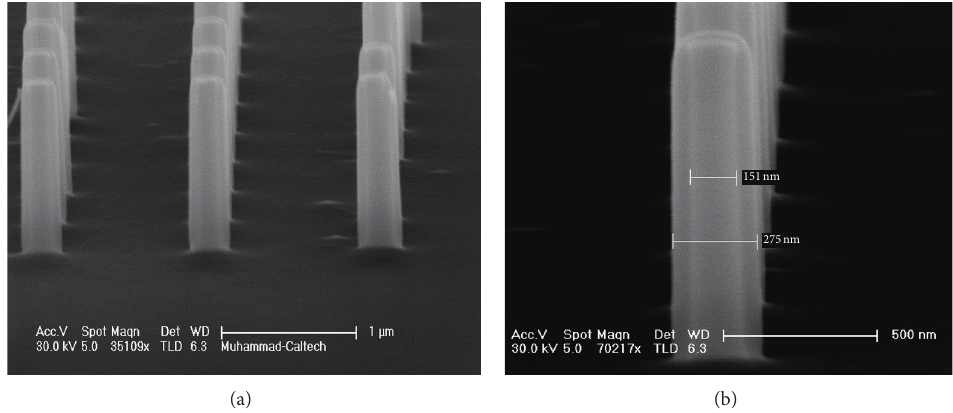
Figure 5: Nanopillars after oxidation. (a) High voltage imaging to confirm the conformality of the oxide layer